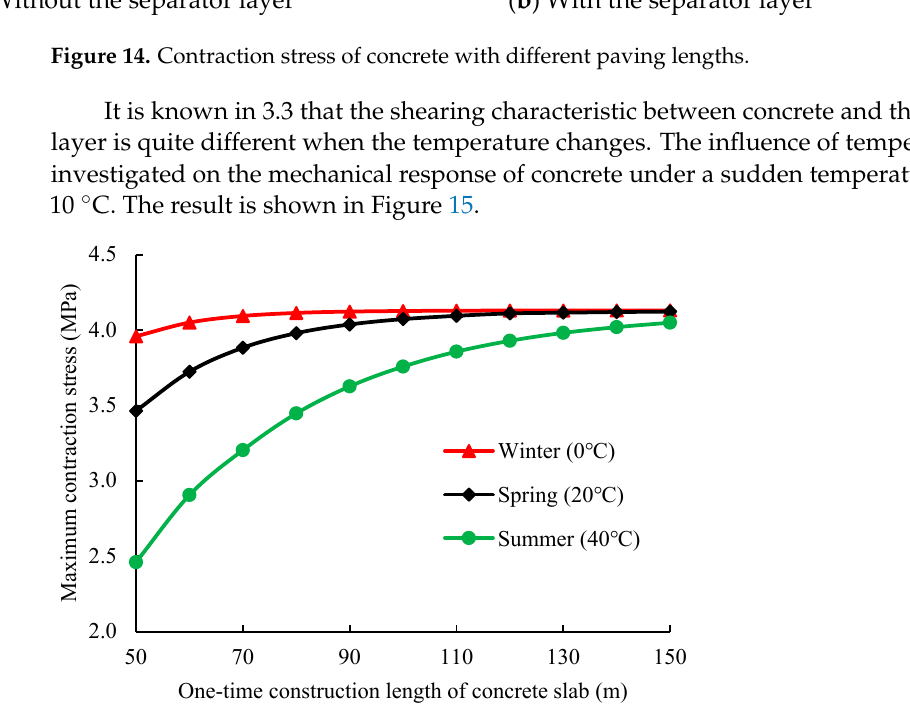
Figure 15. Maximum contraction in concrete slab with separator layer before sawing joints.